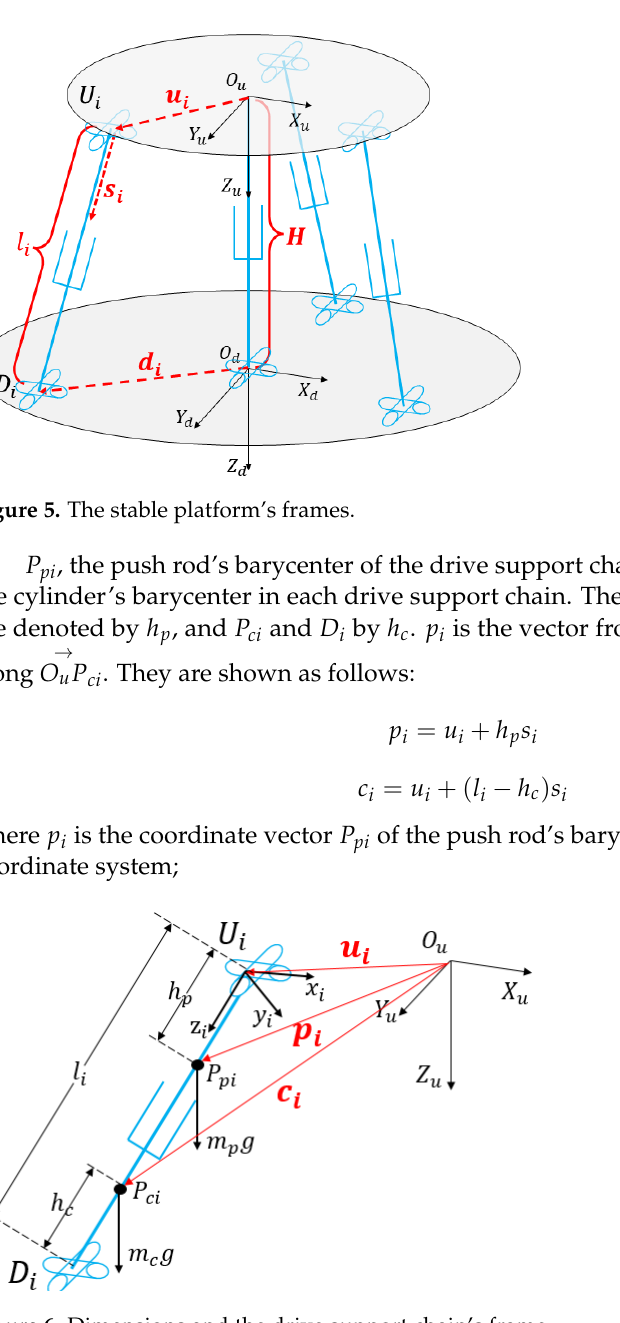
Figure 6. Dimensions and the drive support chain ’ s frame.